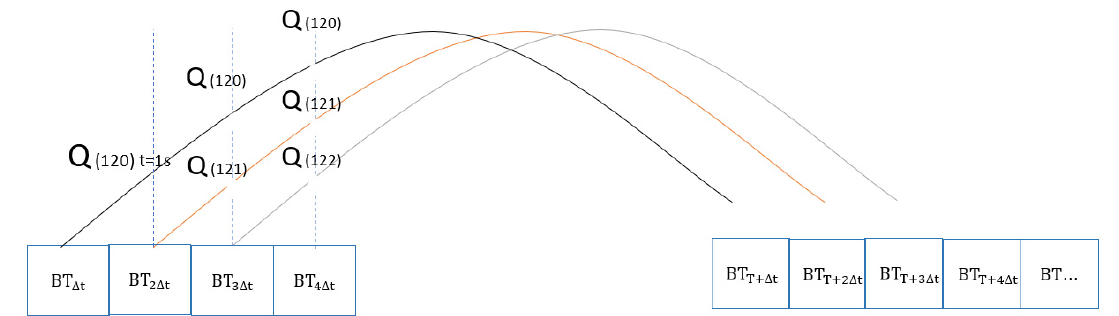
Figure 4. A schematic representing the heat transfer from a Hot spot zone.